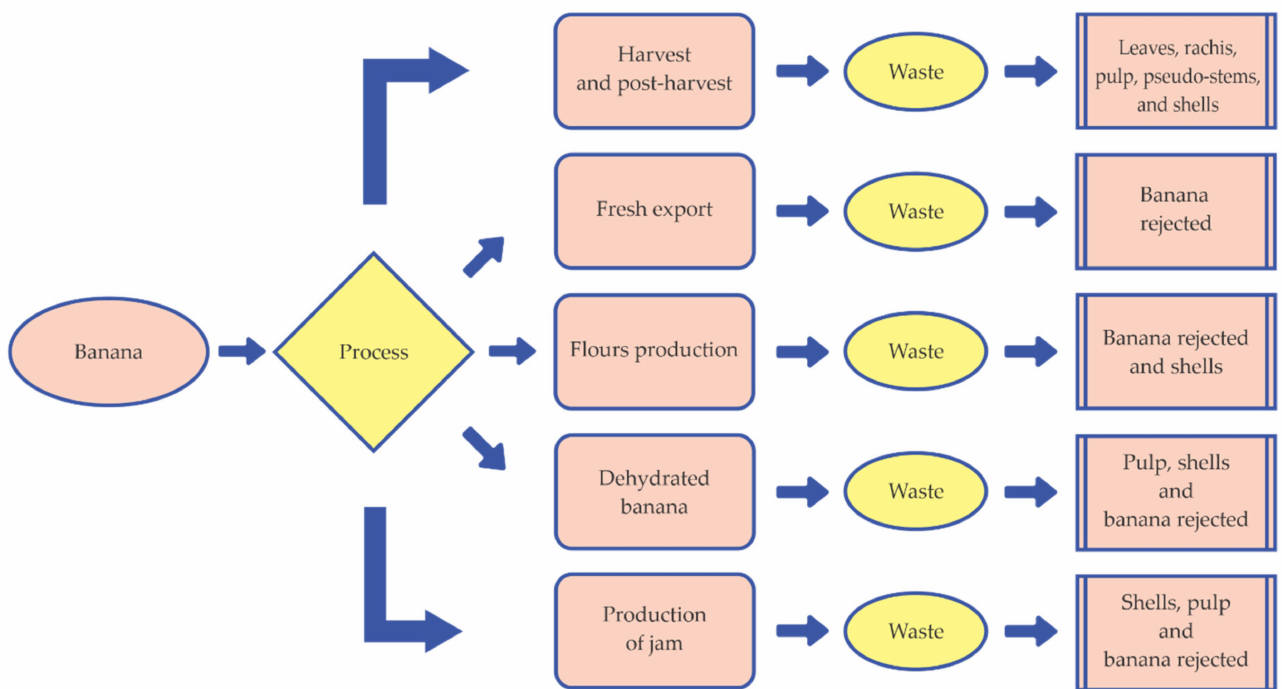
Figure 5. Scheme of production of waste-loss from the banana processing.